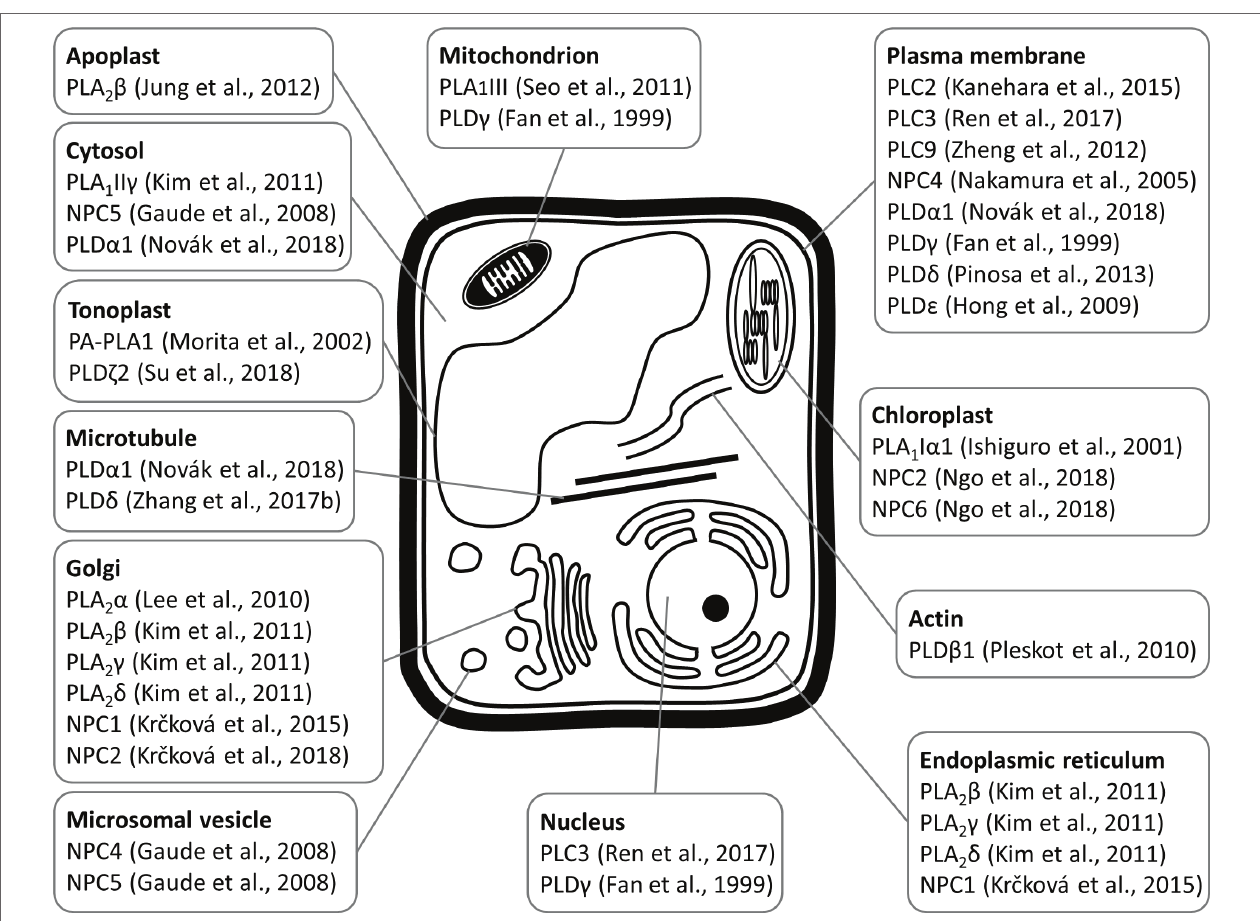
FIGURE 2 | Schematic overview of subcellular localizations of plant phospholipases to diverse subcellular compartments and organelles, as revealed by experimental approaches with relevant citations to the original